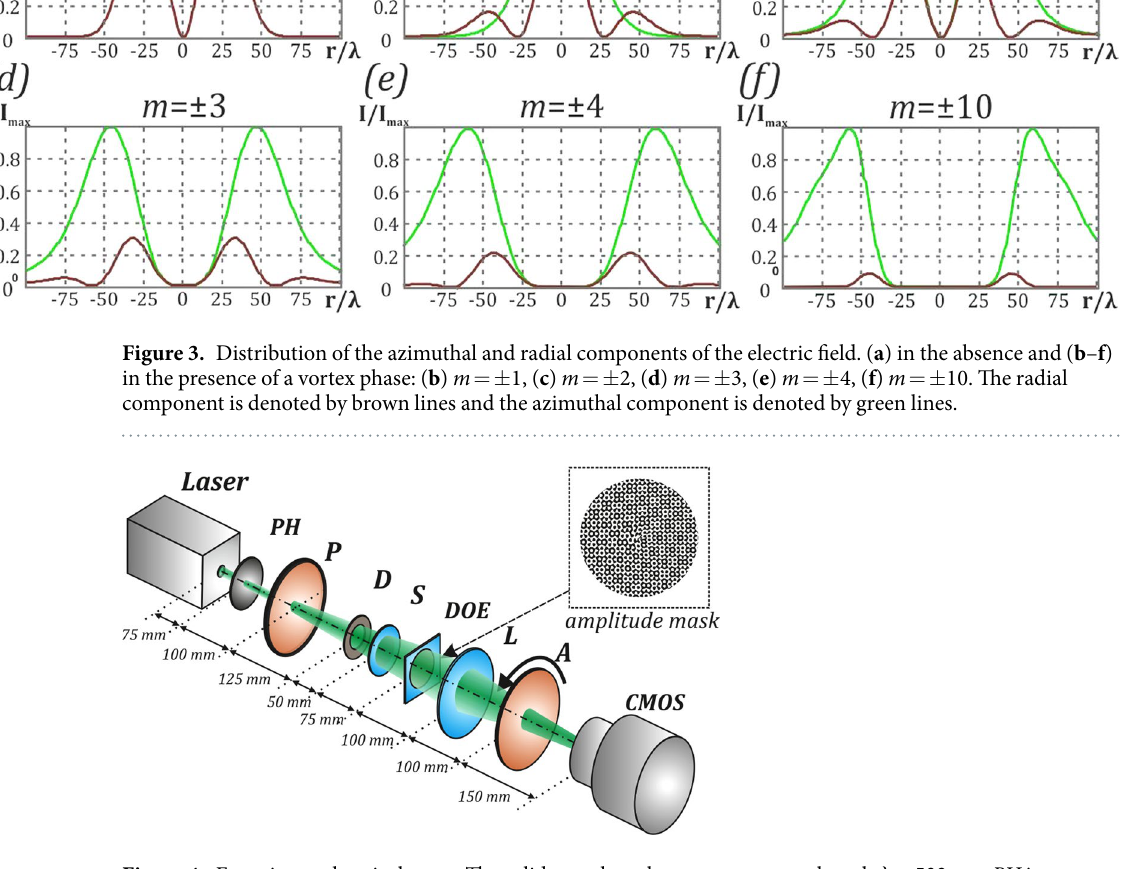
Figure 4. Experimental optical setup. The solid-state laser has an output wavelength λ = 532 nm, PH is a pinhole (100- μ m aperture), P is a polarizer, D is a diaphragm, S is an S -waveplate (radial polarization converter), DOE is an amplitude diffractive optical element forming a superposition of eight vortex beams with orders of ± 1, ± 2, ± 3, and ± 4, L is a lens with a focal length f = 150 mm, A is an analyser, and CMOS is a CMOS-video camera (LOMO TC-1000, 3664 × 2740 pixel